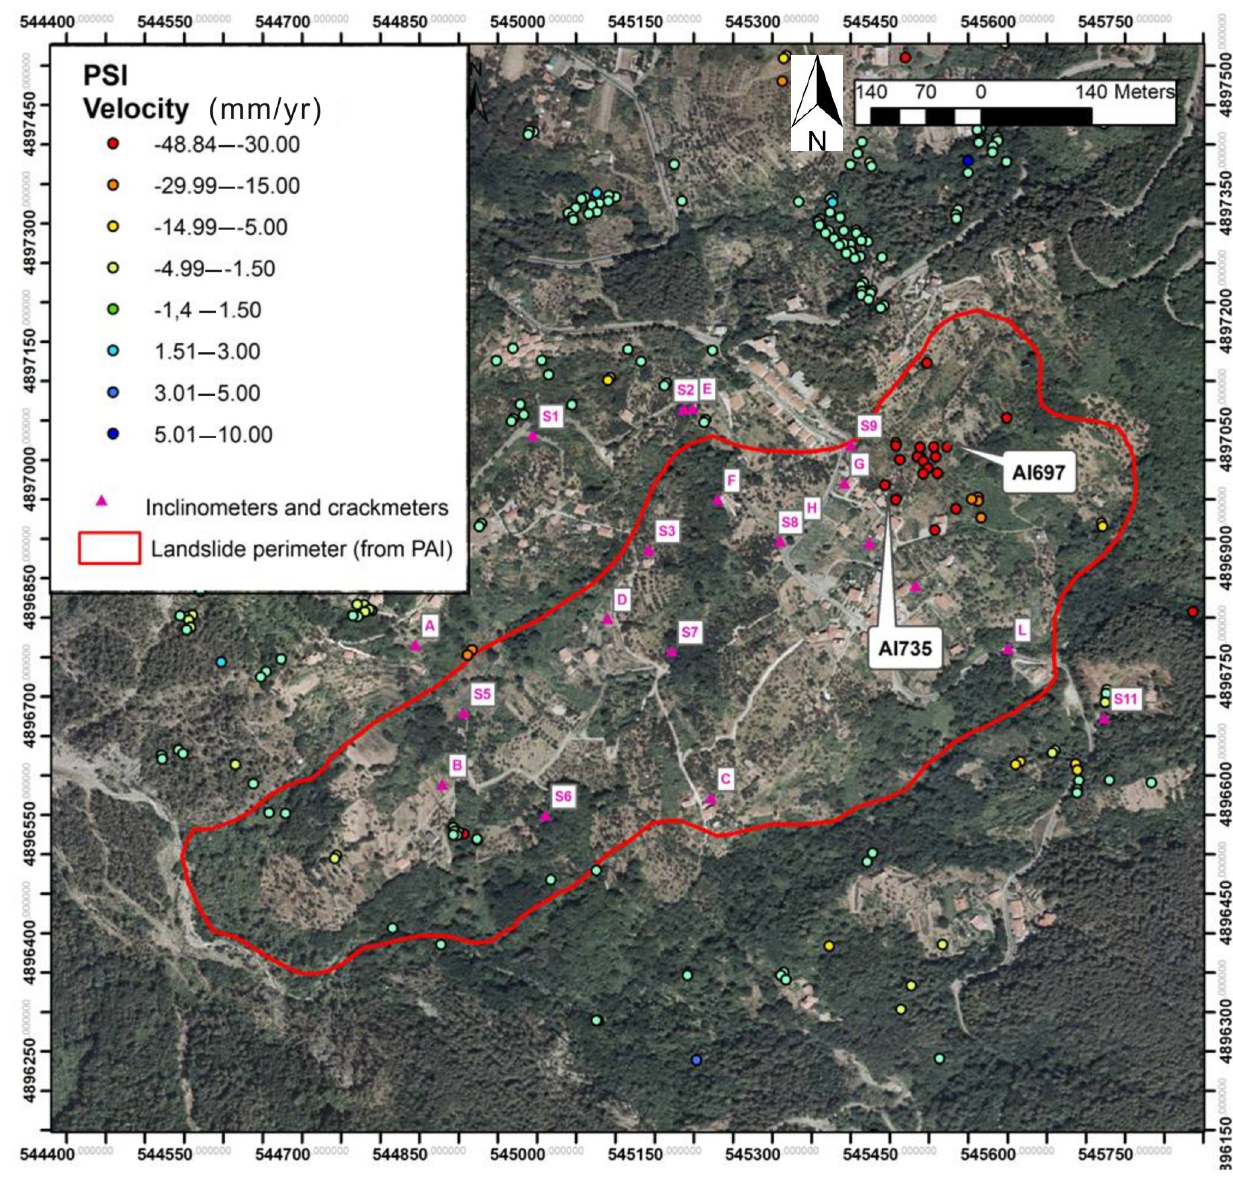
Figure 4. Distribution of radar benchmarks of PSI analysis within landslide perimeter (as reported in PAI